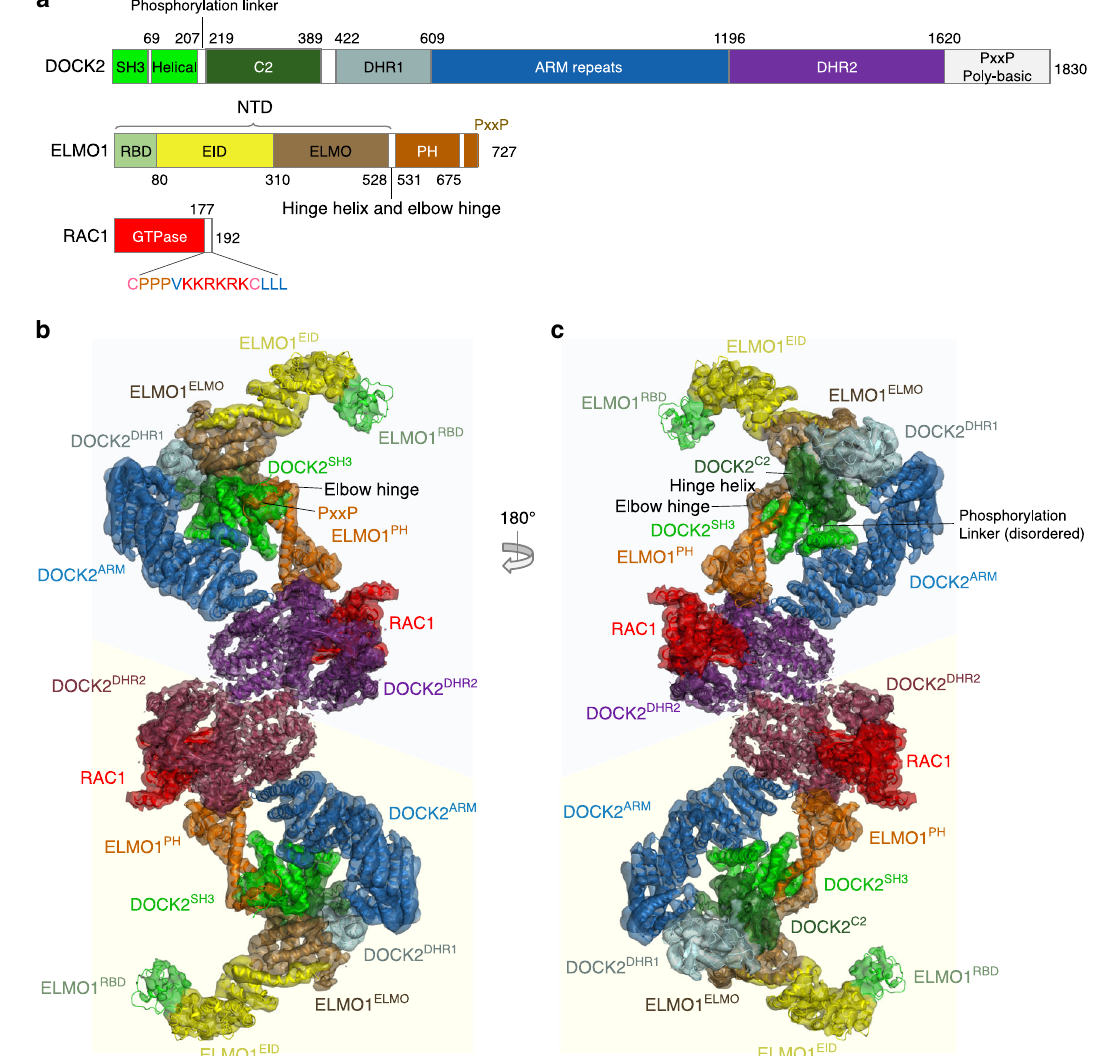
Fig. 1 Overall structure of the DOCK2 − ELMO1 − RAC1 complex. a Schematic of the domain structures of DOCK2, ELMO1 and RAC1. b , c Two views of the cryo-EM map of the DOCK2 − ELMO1 − RAC1 complex with each domain colour-coded. Ribbon representation of the structural models were placed in the cryo-EM density map. The two DOCK2 − ELMO1 − RAC1 protomers of the dimeric complex are indicated by light blue and light yellow backgrounds. The open-conformation of the DOCK2 − ELMO1 − RAC1 complex is